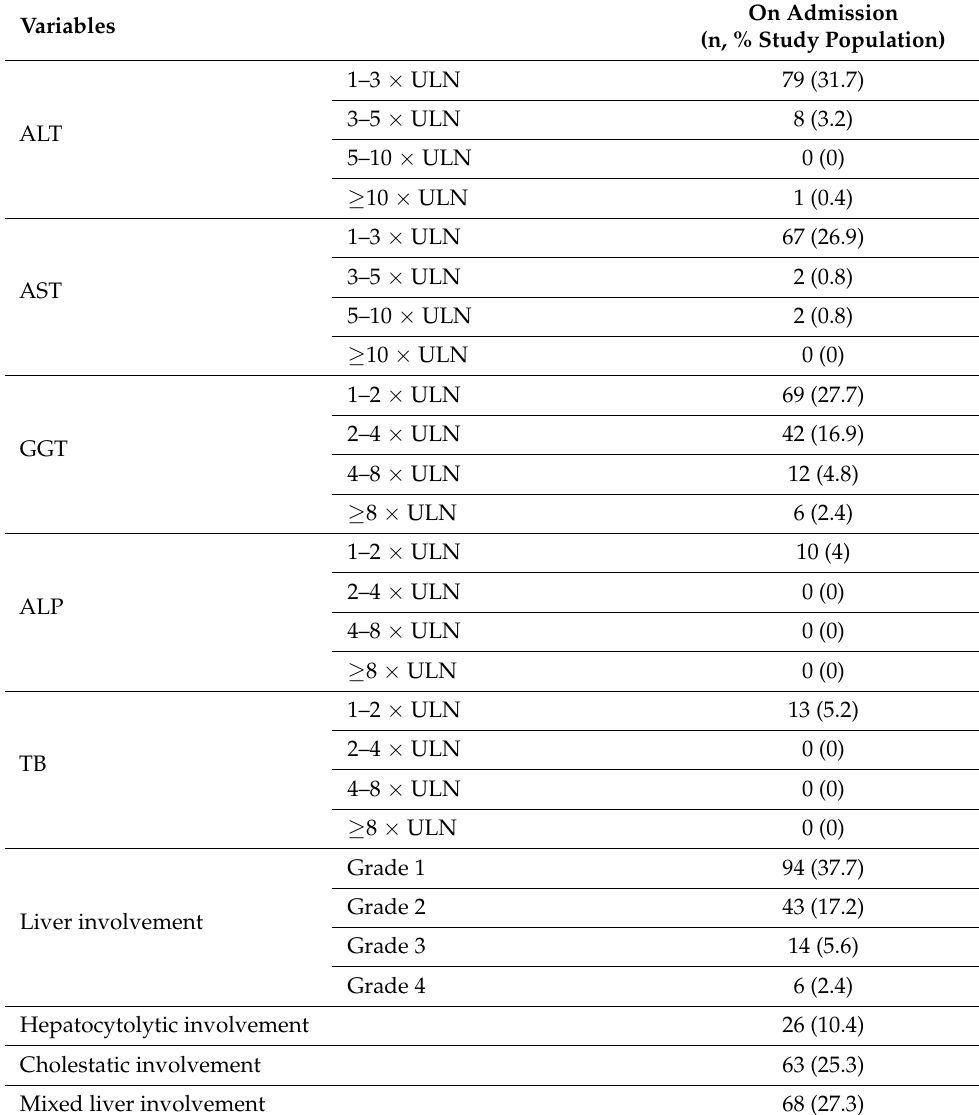
Table 5. Characteristics of liver involvement in patients with